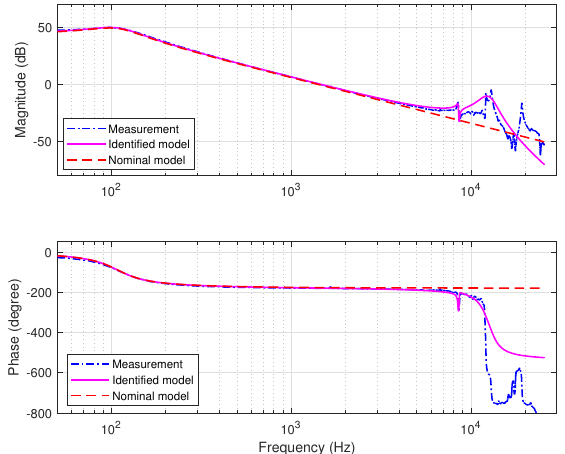
Figure 4. Plant models: measured, identified, and nominal models.